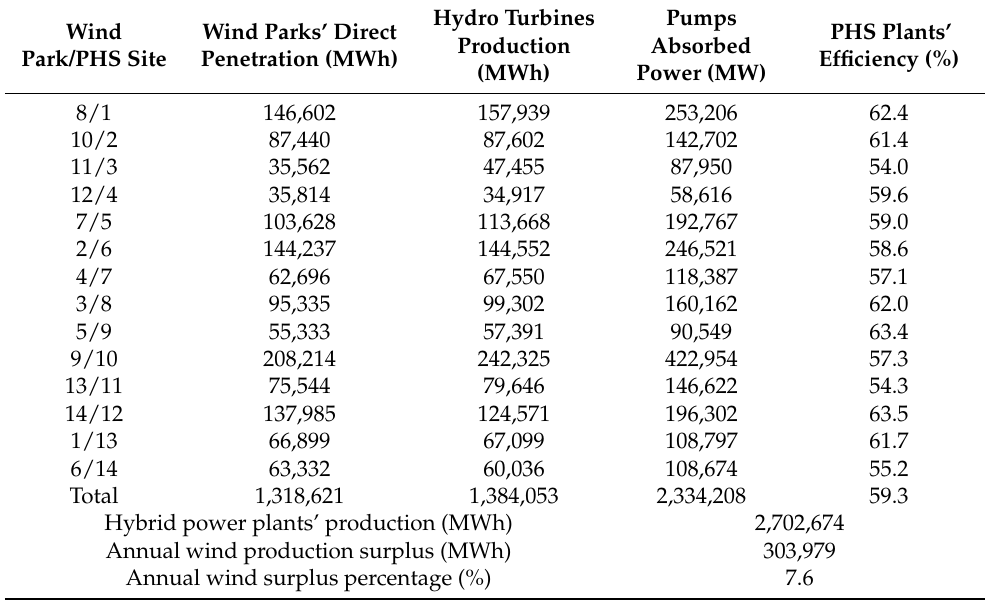
Table 12. Annual electricity production and storage from the 14 wind parks—PHS plants.